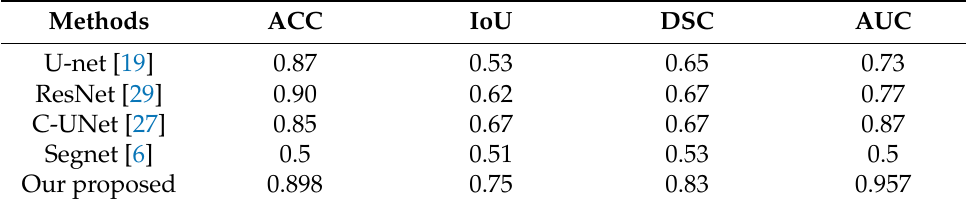
Table 5. Comparison of generalization capabilities on different models.